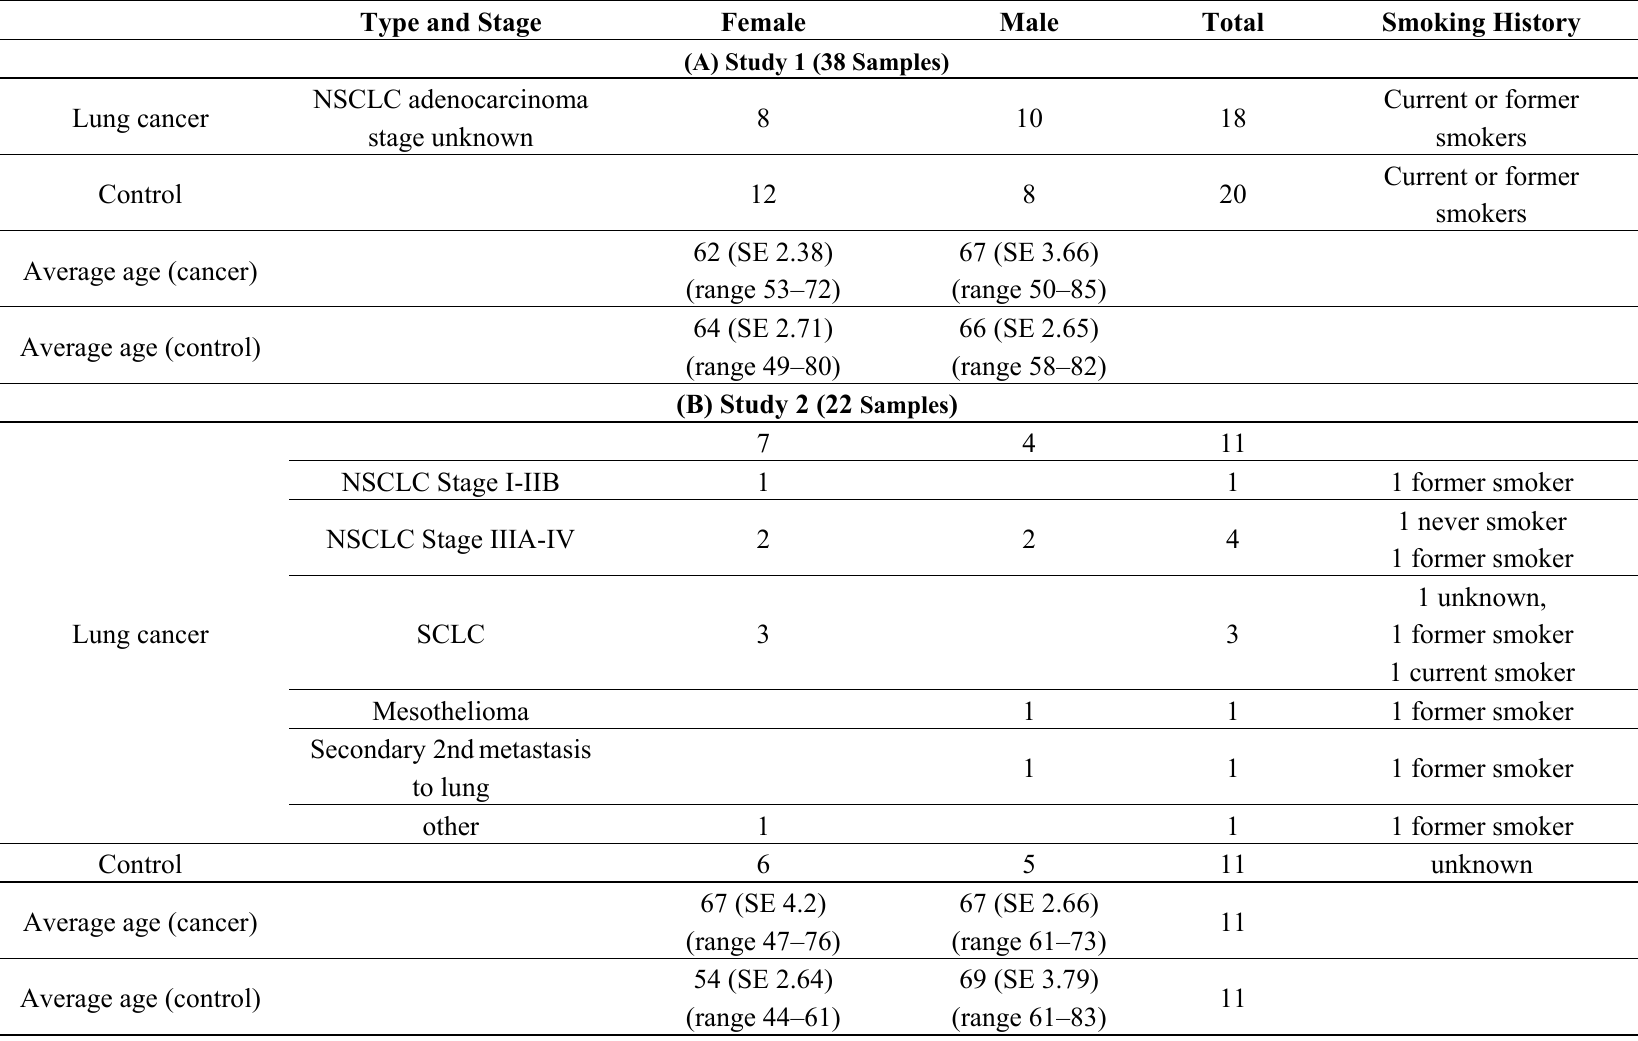
Table 1. Summary of patient information for FHCRC and UCDMC samples. SE is standard error of the